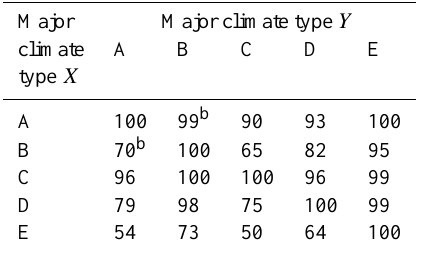
Table 3. Similarity index (SI a ) (%) for the K¨oppen–Geiger major climate types for catchments with a medium soil water supply ca- pacity (Soil II) and intermediately responding groundwater system ( j = 250d).